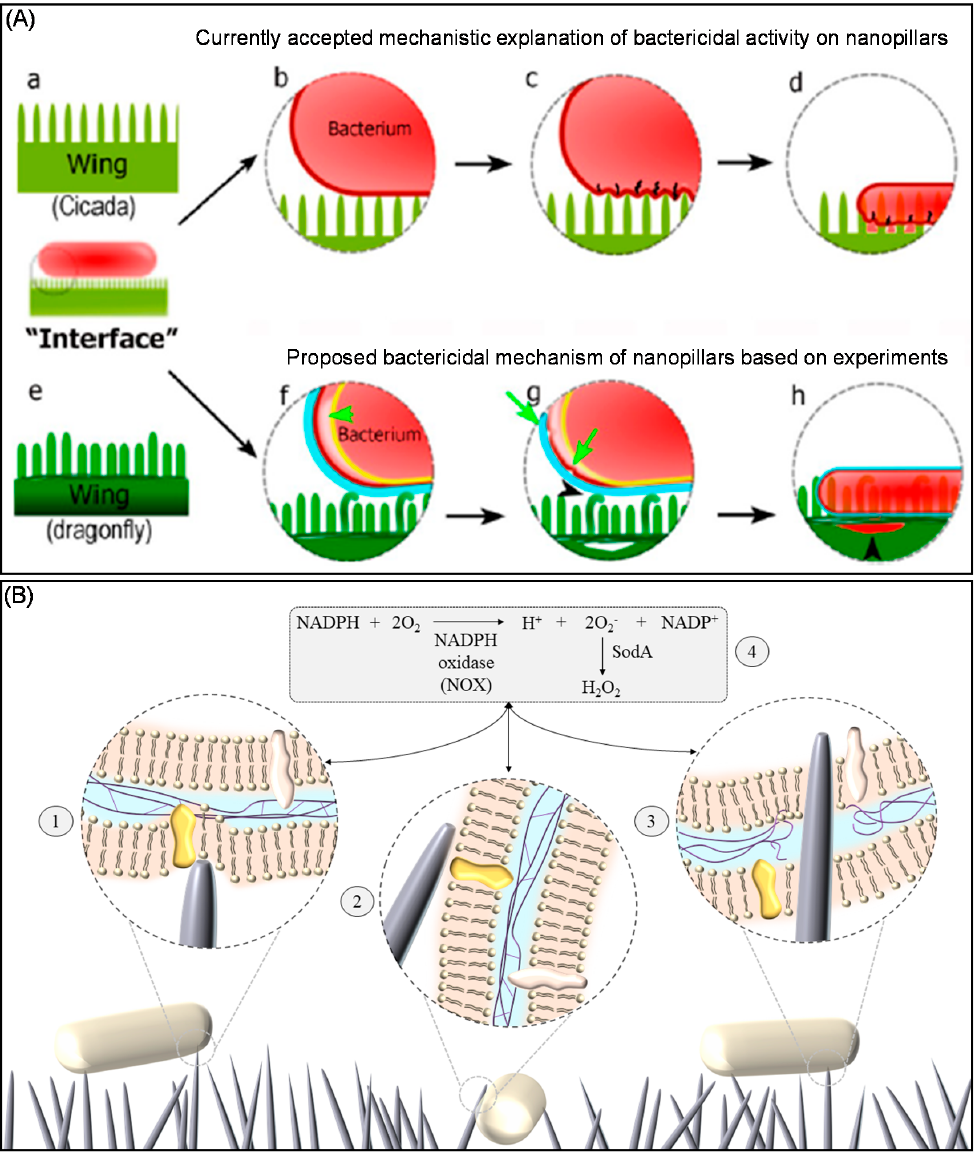
Figure 3. Proposed mechanisms of mechano-bactericidal surfaces. Current accepted bactericidal mechanisms based on cicada wing-like surfaces are shown in A ( a – d ). Since the height of nanopillars on the cicada wing is relatively uniform, there are multiple contact points between the bacterial membrane and the surface upon adhesion. Due to interaction forces, the membrane stretches and eventually ruptures; A ( e – h ) show bactericidal mechanisms proposed for dragonfly wing-like surfaces, which consist of non-uniform high aspect ratio nanopillars, meaning that initial contact points are expected to be fewer than for the cicada wing. Interactions with bacteria cause the nanopillars to bend instead of puncturing or rupturing the bacterial membrane. Due to adhesion force, the cell membrane starts to wrinkle and form blebs, which eventually causes the cytosol to leak out [reproduced with permission from Ref. [40]]; ( B ) Proposed possible interrelated antibacterial mechanisms of nanopillared TiO 2 surfaces. (1) Some bacteria may experience cell membrane deformation when adhering between nanopillars, leading to cell impedance and impaired cell replication. (2) If the deformation reaches the elastic limit of the cell envelope, the nanopillars can penetrate the cell envelope. (3) The physiological interactions between bacteria and nanopillars can result in an oxidative stress response and induce the production of reactive oxygen species (ROS),